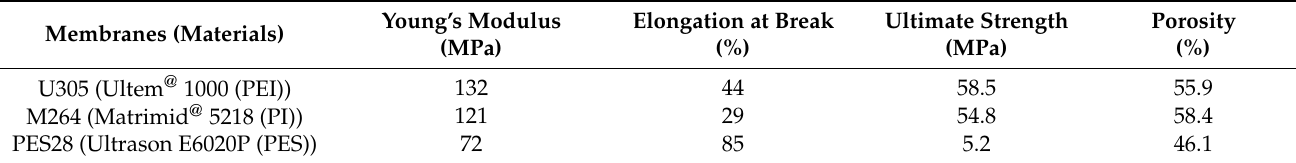
Table 2. Physical and mechanical characteristics of membranes.